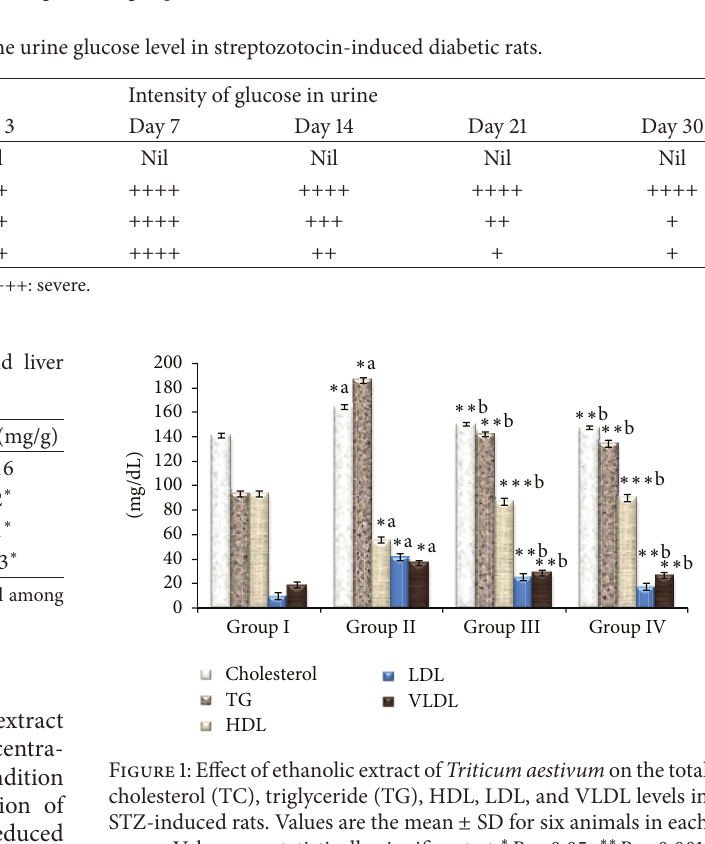
rats. The administration of Triticum aestivum 100 mg/kg and